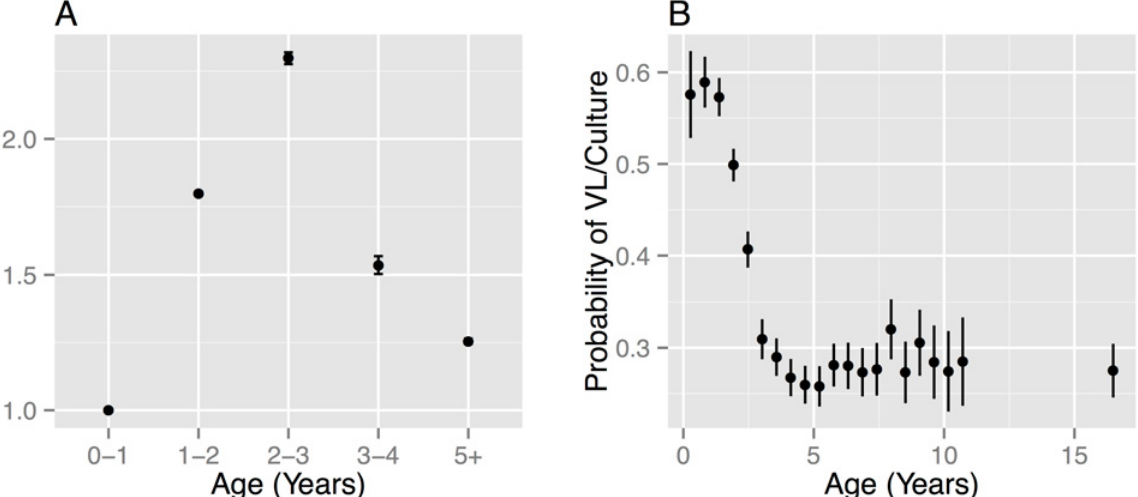
Fig 1. Age-stratified patterns of reactors in Great Britain. A The relative risk of infection by age RR(a) measured relative to the risk for 0 – 1 year old cattle, Error bars denote 95% credible intervals. RR(a) is calculated as the ratio of the force of infection for each age group divided by the estimate for the 0 – 1 year old group. The force of infection is a combined estimate for all national herds (beef and dairy) calculated from reactor cattle reported between 2004 – 2009 as described in [21]. B The probability of “ confirmation ” of reactor animals by the presence of visible lesions or culture as a function of age at slaughter, estimated as the proportion of reactor animals within each (200 day) age-class that demonstrated visible lesions or a positive culture result. Estimates are calculated using all reactor animals from within our study population of herds. The qualitative pattern is robust between different test-types and parish testing intervals